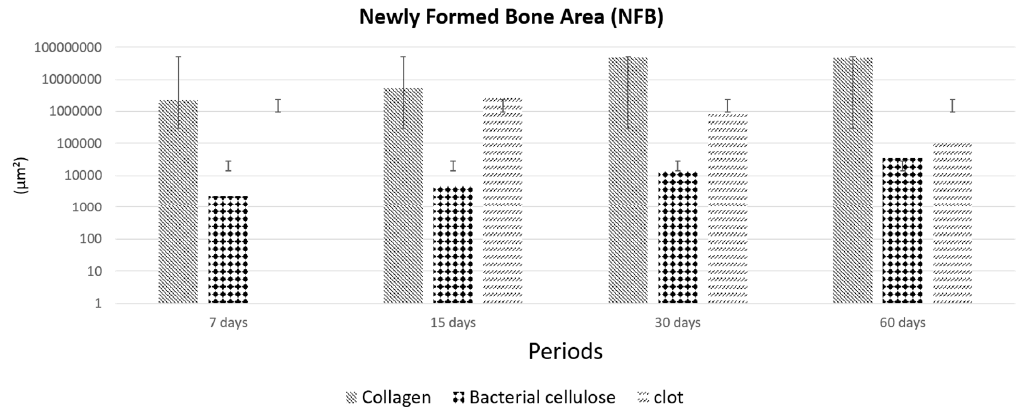
Figure 7. Graph comparing the areas of bone formation between the groups and periods analyzed.